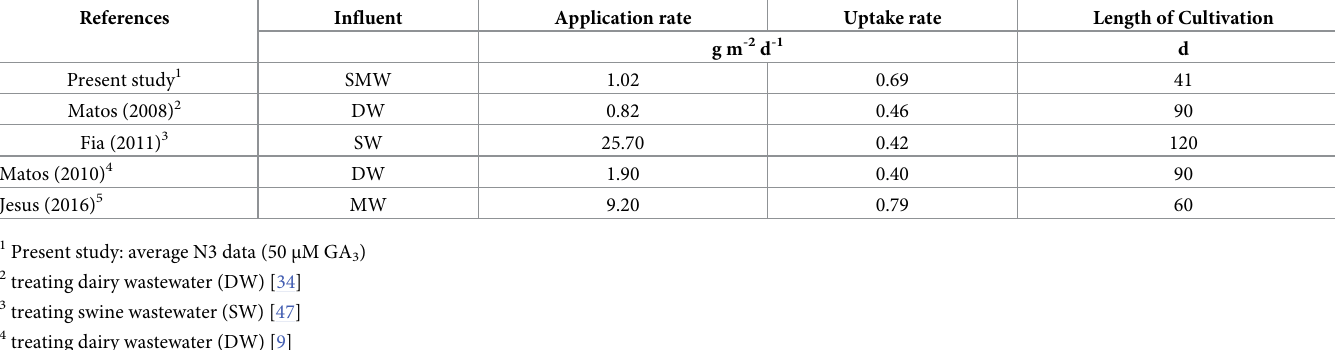
Table 11. Revision of application rates and total nitrogen uptake rates by Tifton 85 bermudagrass in